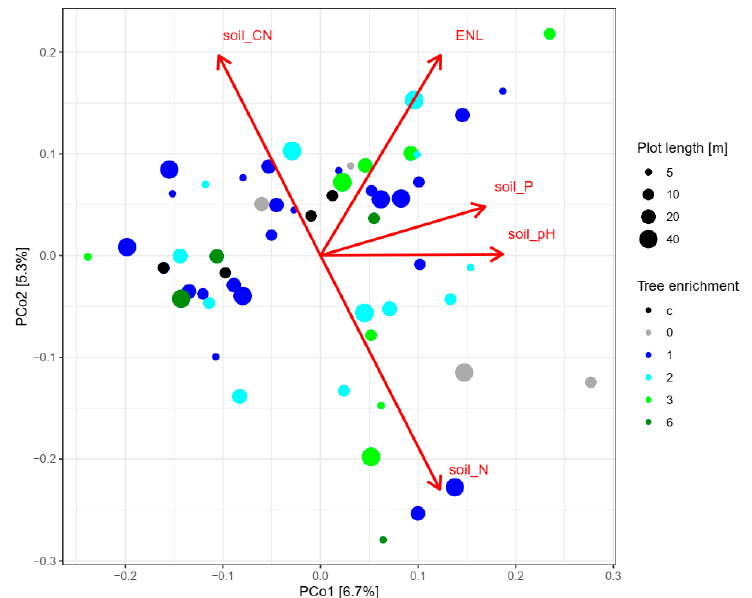
Figure 3. Principal coordinate analysis (PCoA) of fungal OTU community Bray–Curtis dissimilarity. Colors denote the number of planted tree species and point sizes indicate the size of enrichment plots. Red arrows show the significant linear effect of environmental variables ( p < 0.05) associated with the ordination axes. N: nitrogen, C/N: carbon-to-nitrogen ratio, P: phosphorus, ENL: effective number of layers, c: oil palm control plots with management as usual.